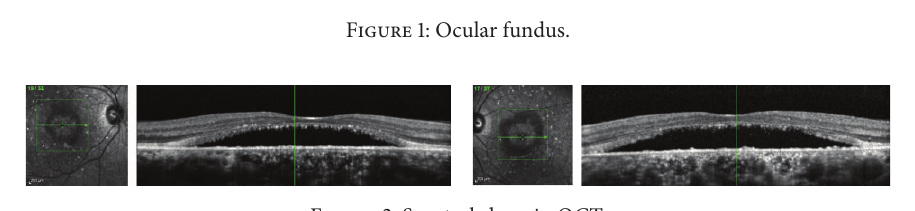
Figure 2: Spectral-domain OCT.